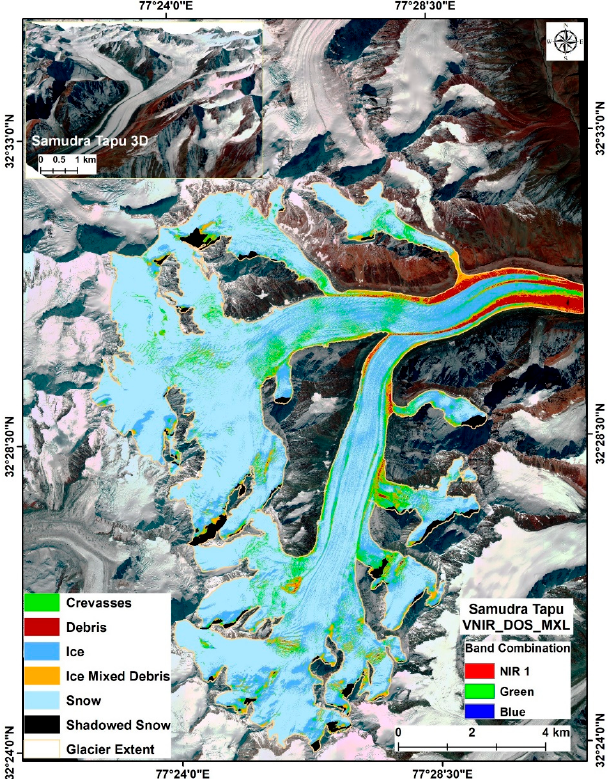
Figure 6. MXL classification of VNIR_DOS processing scheme of the ST glacier. Background image: WorldView-2 © 2014 Maxar.